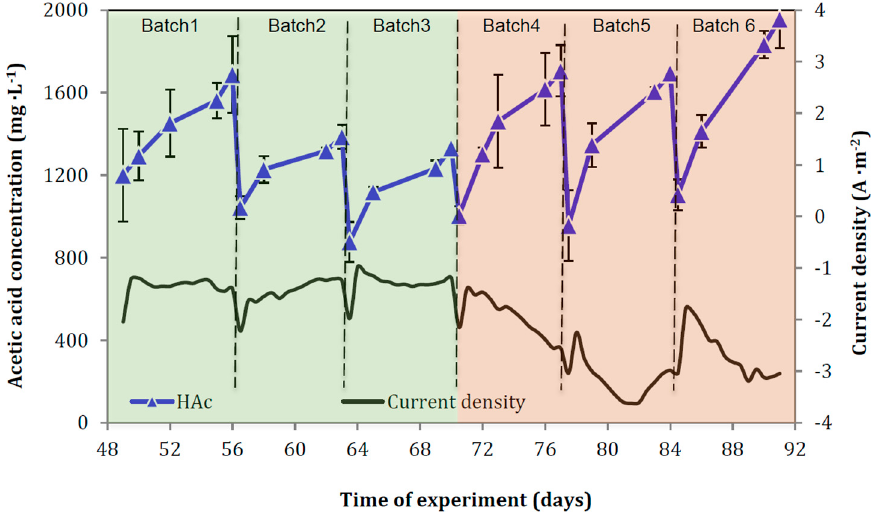
Figure 3. Acetic acid concentration along the experimental period (days 49–92). Current density is also shown along the whole period. The green area represents the 3 batch cycles with no gas headspace recirculation, while orange covers the 3 batches with recirculation.